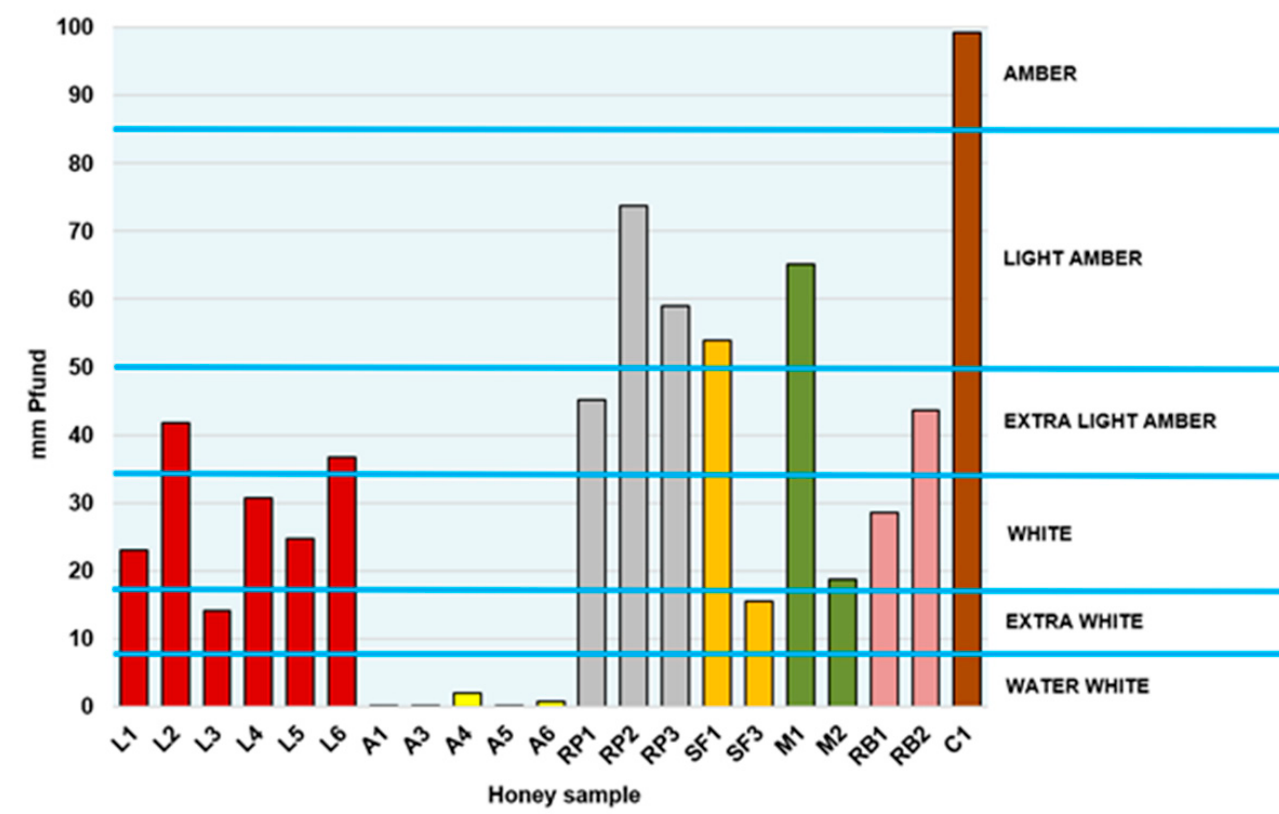
Table 4 lists the concentrations of mineral elements in the analyzed honeys.